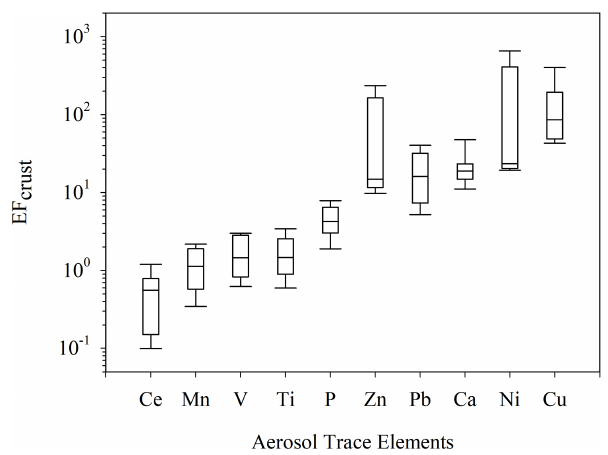
Figure 3. Box plots of EF crust for trace elements in aerosols col- lected at Palmer Station between November 2016 and January 2017. The central horizontal line is the mean value, and the bottom and the top of each box are the 25th and 75th percentiles. The upper and lower horizontal bars indicate the 5th and 95th percentiles of the